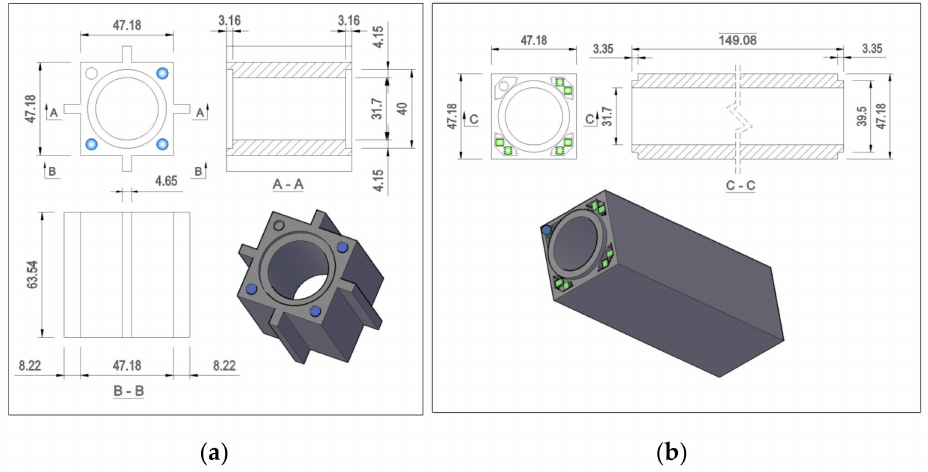
Figure 3. ( a ) Interstitial brick dimensions. ( b ) Filler brick